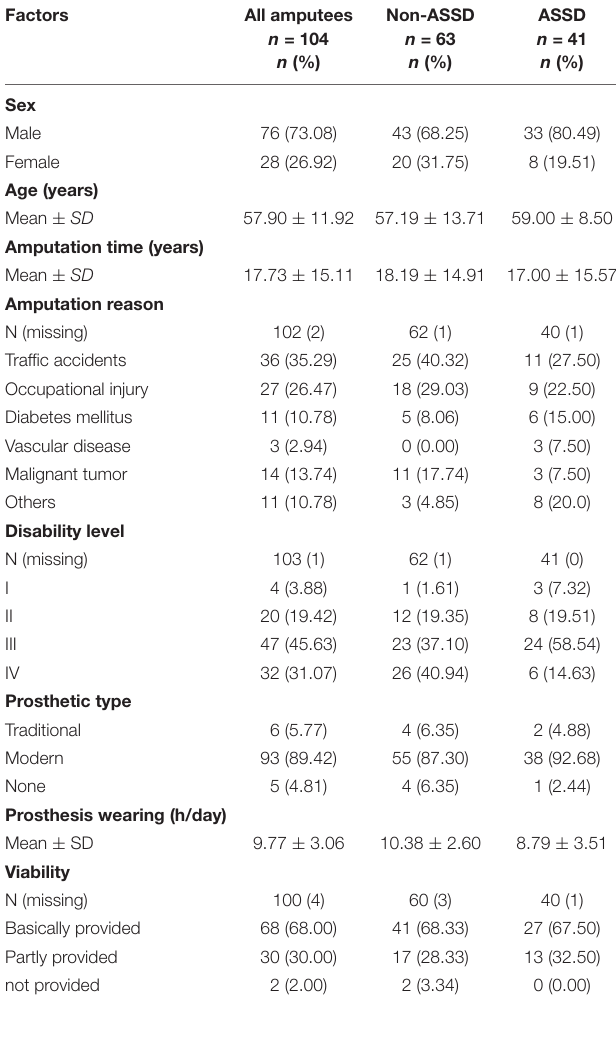
TABLE 2 | Demographic and clinical characteristics of amputees and those with or without